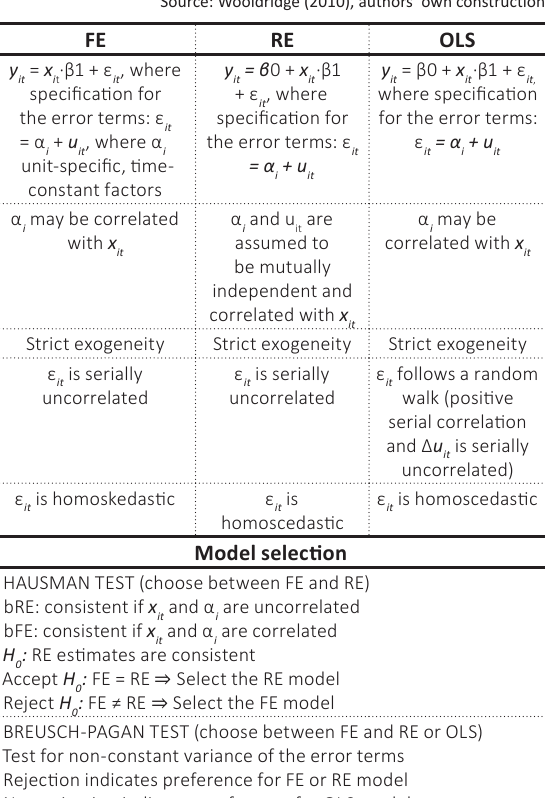
Table 2. Differences between FE, RE and OLS estimators